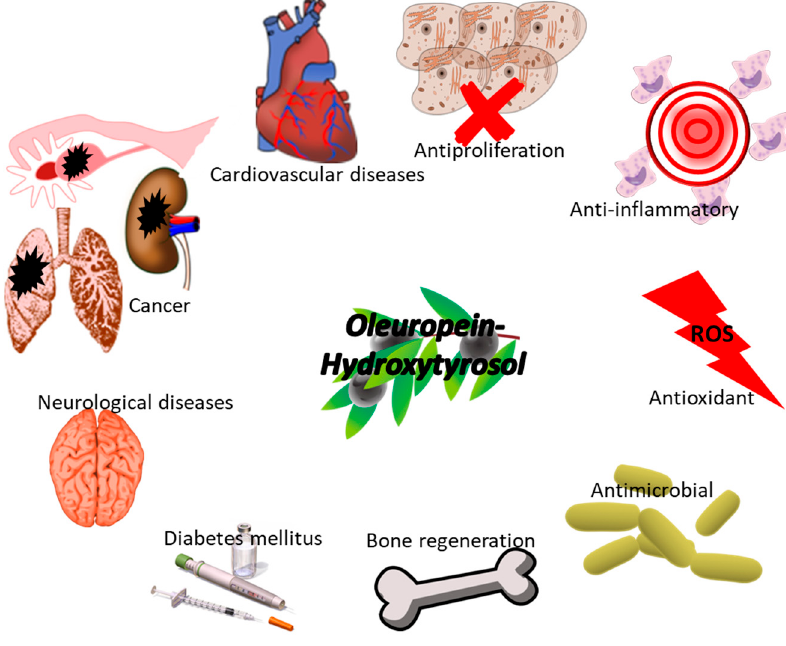
Figure 3. Biological activity of OLE and Htyr for human wellness.